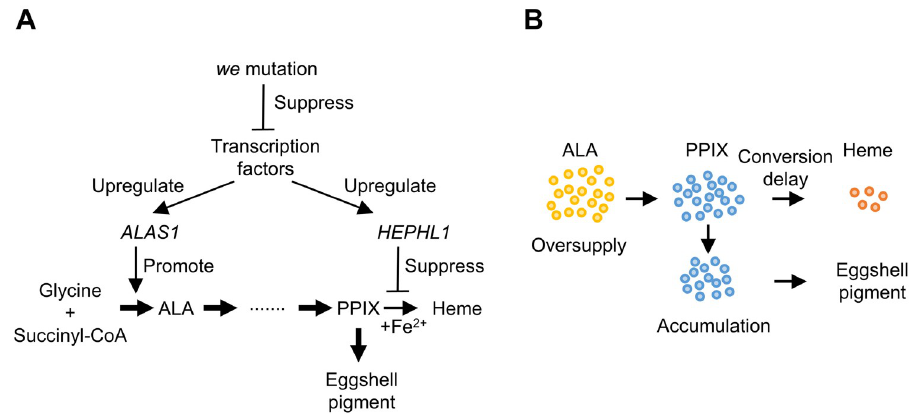
Fig 7. Hypothetical model of PPIX production in the uterus of Japanese quail. (A) Hypothetical model of the uterus-specific regulation of heme biosynthesis and underlying transcriptional regulation. Transcription factors may increase the expression levels of ALAS1 and HEPHL1 in the uterus. The upregulated expression of ALAS1 may enhance ALA synthesis, and facilitate the excessive production of PPIX by uterine cells, leading to its accumulation by exceeding the conversion of PPIX to heme. In addition, HEPHL1, a predicted ferroxidase, may suppress the conversion of PPIX to heme by decreasing the intracellular or intramitochondrial ferrous ions, which may accelerate the accumulation of PPIX. (B) Schematic diagram of PPIX accumulation in the uterine